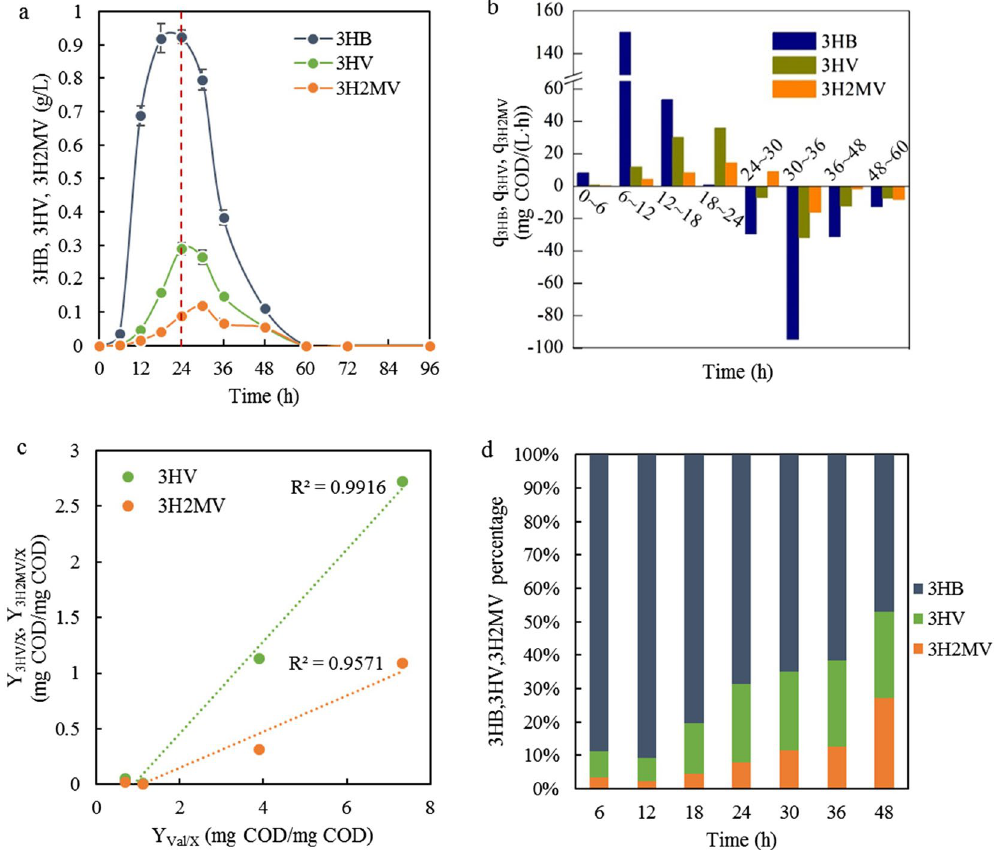
Figure 3. Profiles of 3HB, 3HV and 3H2MV monomers ( a ), their production and degradation rates (negative values) ( b ), the effects of valerate accessibility on 3HV and 3H2MV production in feast phase ( c ), and the monomers proportion ( d ) during one cycle in the SBR operated under stability. Red dashed lines mark the end of feast phase. The percentages of 3HB, 3HV and 3H2MV are on molar carbon basis. (bars = S.D., n =